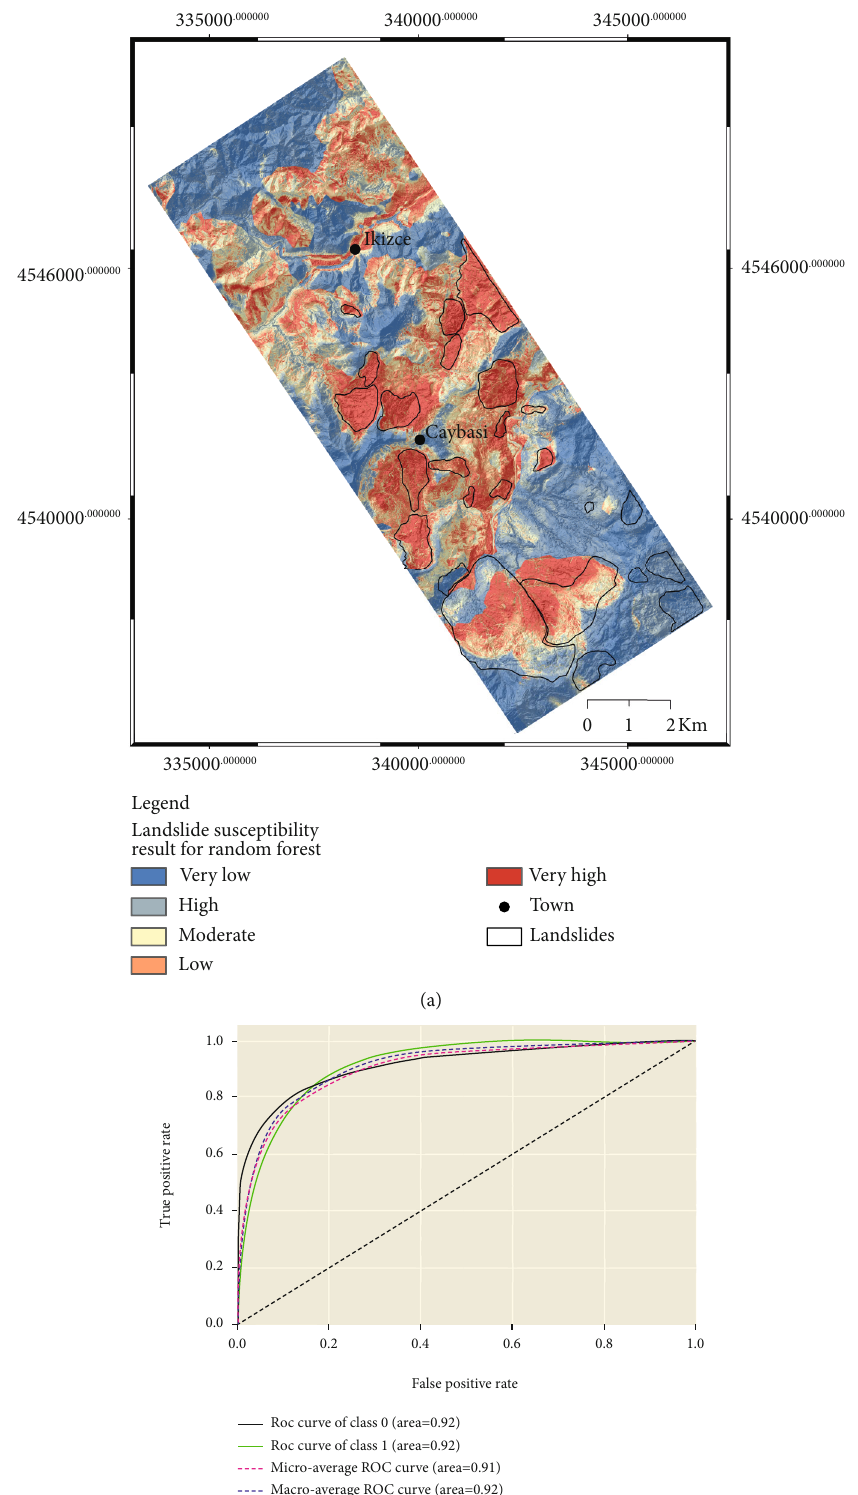
Figure 14: Landslide susceptibility map of Ikizce-Caybasi area (a) and the ROC curves obtained from the RF model